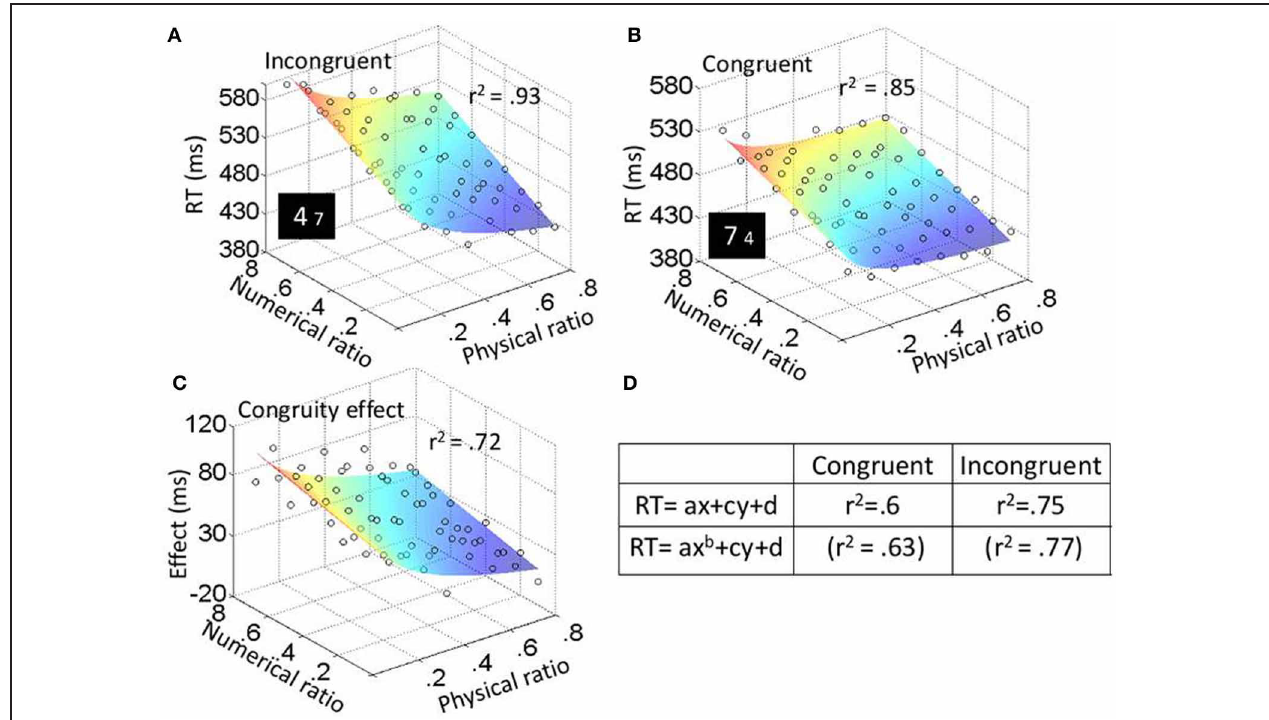
FIGURE 5 | Experiment 2: numerical task results. Average RT (for every participant in every condition) was plotted as a function of both physical ( x -axis) and numerical ( y -axis) ratios. The color of the surface represent RTs—blue is for the lowest RTs and red for the